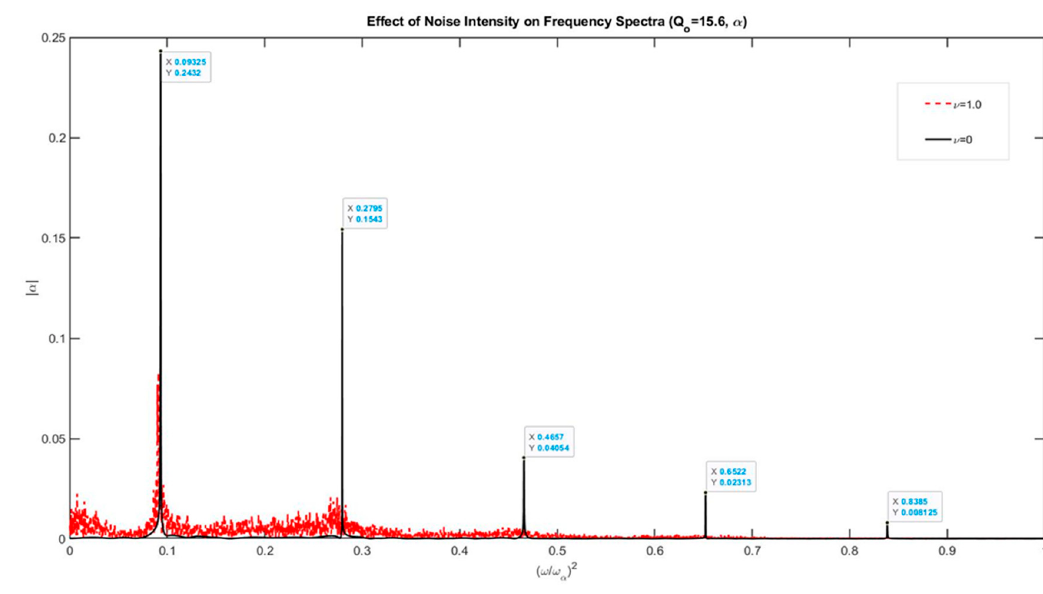
Figure 29. A comparison of frequency spectra ( 𝛼 ).